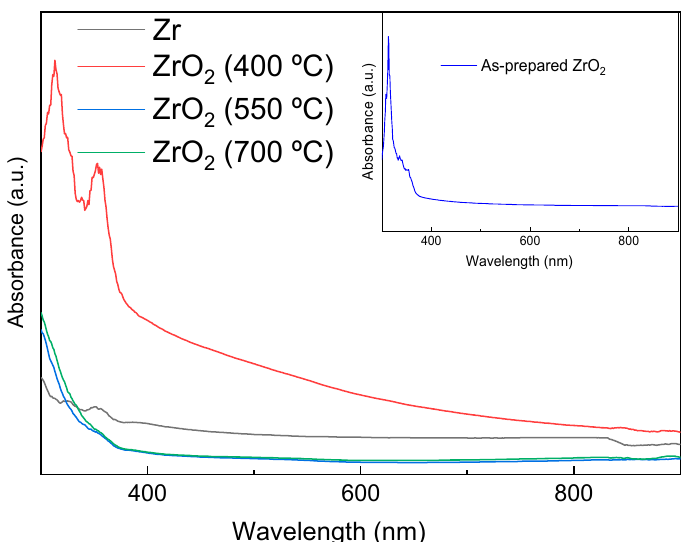
Figure 8. The light absorption spectra of unannealed ZrO 2 and annealed ZrO 2 NTs at different temperatures (400, 550, and 700 °C).